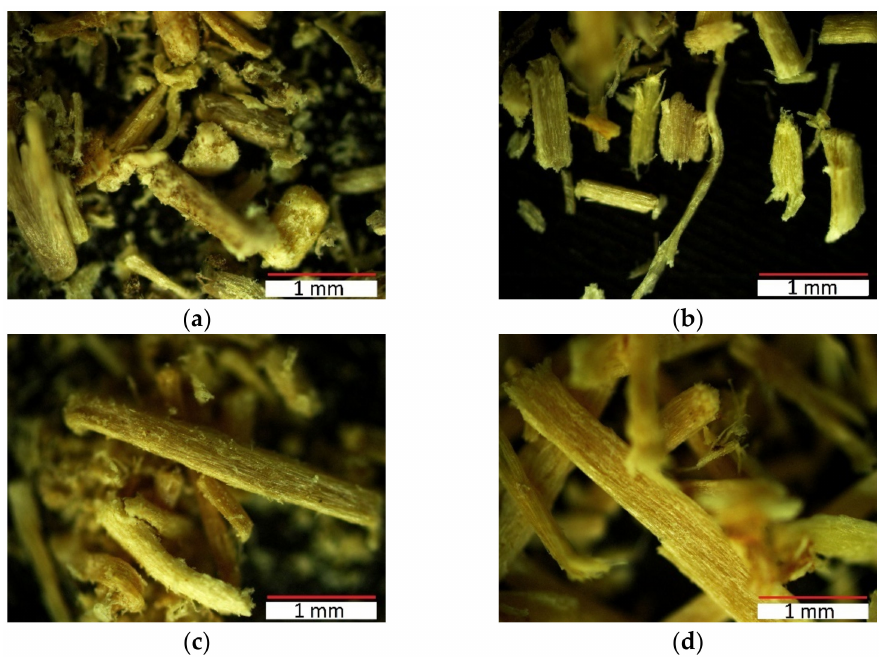
Figure A1. Optical microscope images of ground fibres obtained directly from nature: ( a ) OMF.N.D, ( b ) OMF.N.NaOH.D, ( c ) ODF.N.D, ( d )